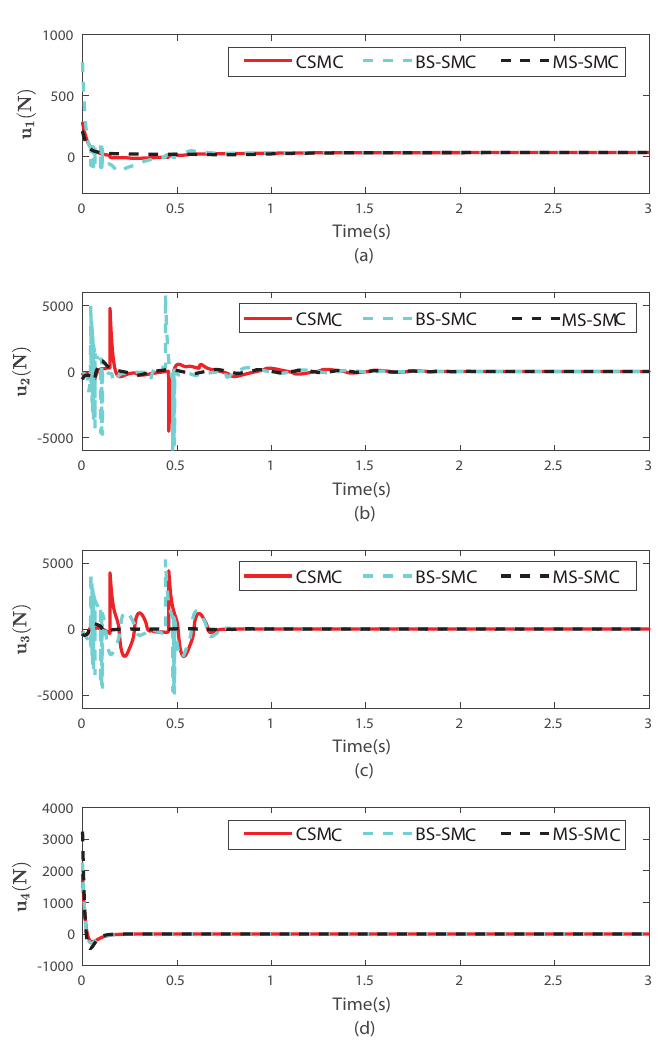
Figure 6. Control inputs of overall system: ( a ) control input for lifting force, ( b ) control input for pitch angle, ( c ) control input for roll angle, and ( d ) control input for yaw